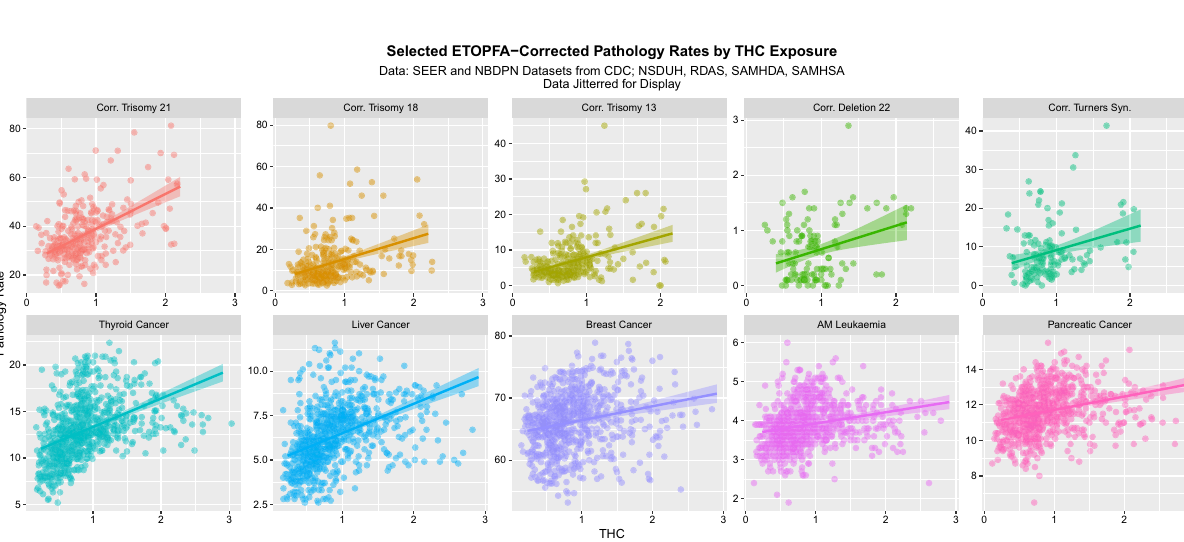
Figure 6. Paired scatterplot matrix for the covariates in the cancer dataset. (Created in R-Studio version 1.3.1093 using ggplot2 version